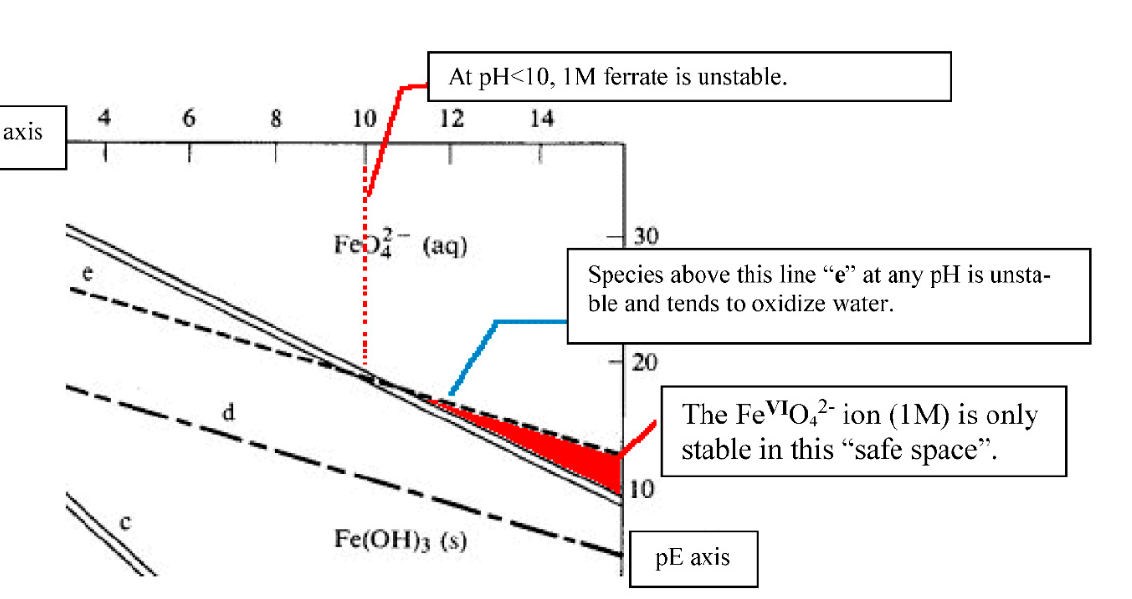
Figure 6. Pourbaix diagram of iron based on 1M ferrate(VI) at 25 °C [117].